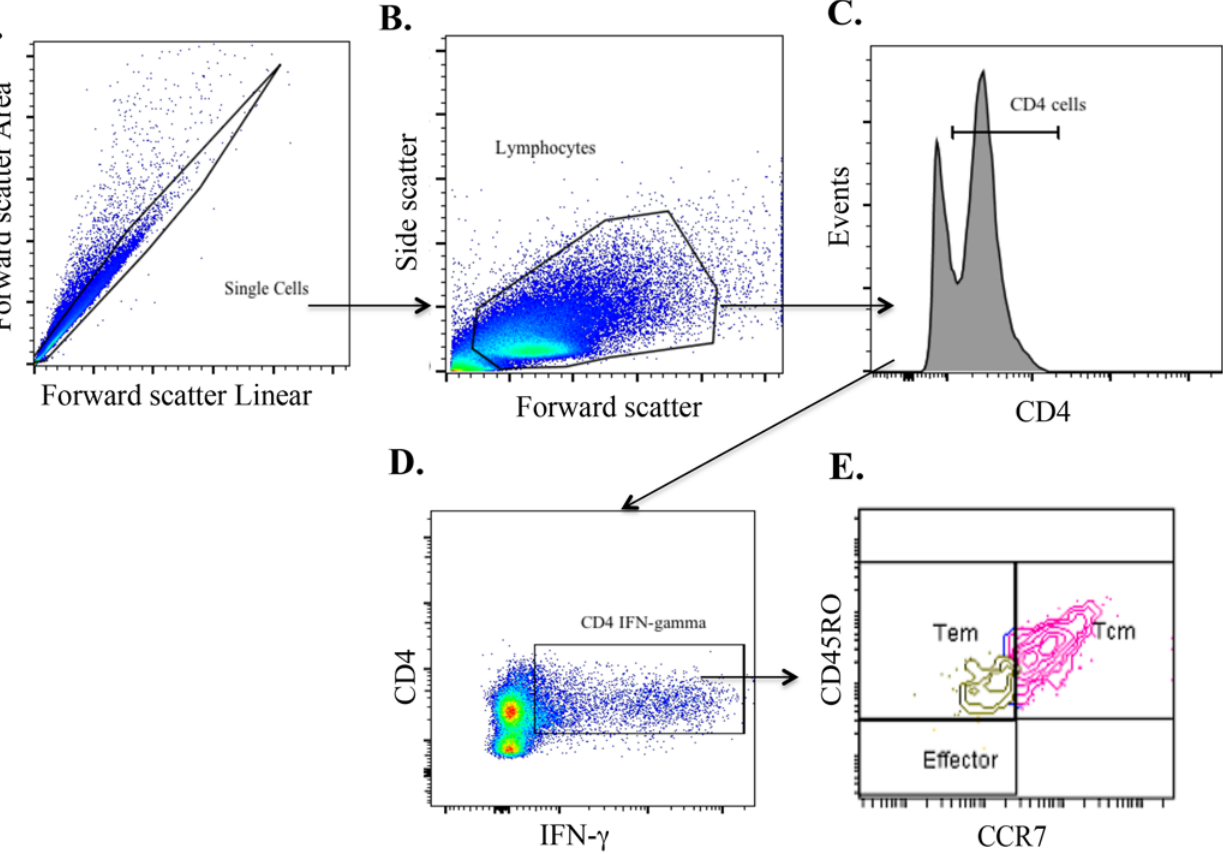
Fig 2. Representative gating strategy for evaluation of CD45RO and CCR7 expression on CD4 T cells producing IFN- γ . Approximately 8 weeks after aerosol challenge with M . bovis , long-term cultures were generated by stimulating PBMC with a cocktail of rAg85A (1 μ g/ml), rTB10.4 (1 μ g/ml) and rESAT-6: CFP10 (1 μ g/ml) as well as PPDb (5 μ g/ml) for 13 days followed by transfer of cells to ELISPOT plates with APCs and restimulation with PPDb. Gating hierarchy (gating sequence as depicted by the arrows): (A) Single cells (within the oblong gate), (B) Lymphocytes (within the polygon gate), (C) CD4 + cells, (D) CD4 + cells producing IFN- γ , and (E) CD45RO and CCR7 expression for determination of effector/memory